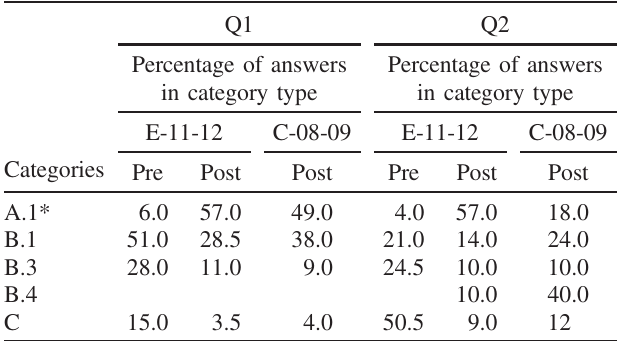
TABLE III. Results for questions Q1 and Q2: (*) Correct answer. Experimental groups in Spring 11 and Spring 12 (E-11- 12). Comparison groups in Spring 08 and Spring 09 (C-08-09).